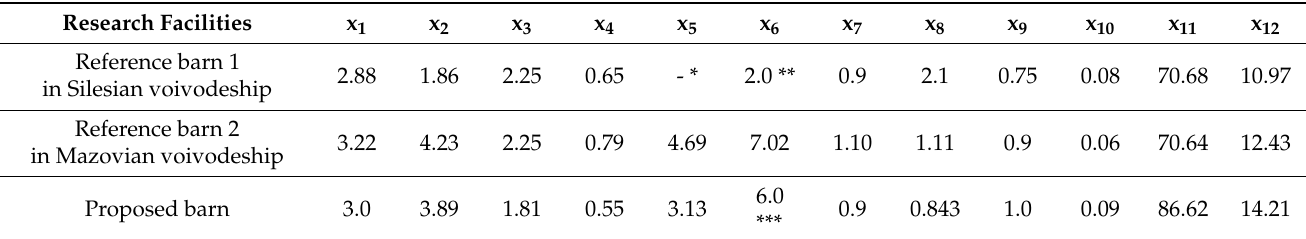
Table 2. Parameters of technical indicators shaping animal welfare in the building of the proposed cowshed (own tests). Research